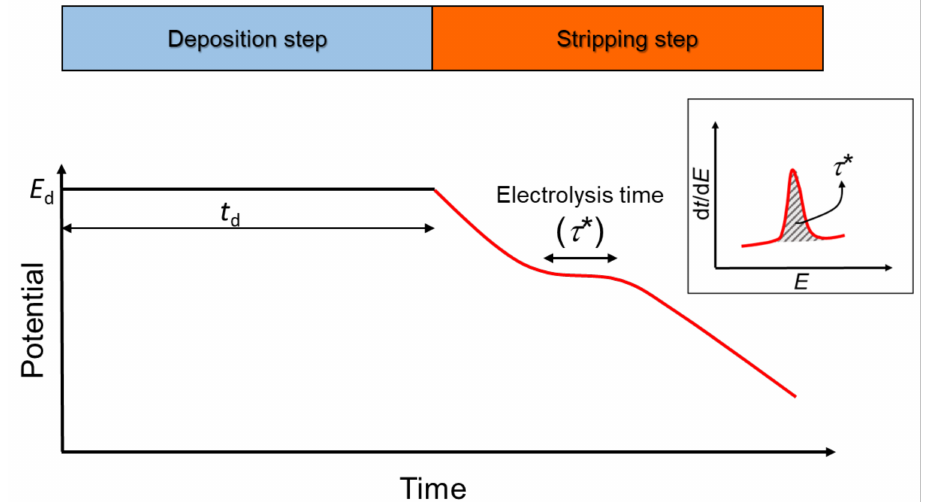
Figure 1. Time-dependence of the potential during stripping chronopotentiometry (SCP). These measurements are conducted using a defined deposition time ( t d of 45, 90, 180 and 240 s in this work) and a suitable deposition potential ( E d ), depending on the metal of interest—normally, − 0.75 V for Cd(II) and Pb(II) and − 1.35 V for Zn(II) vs. Ag/AgCl